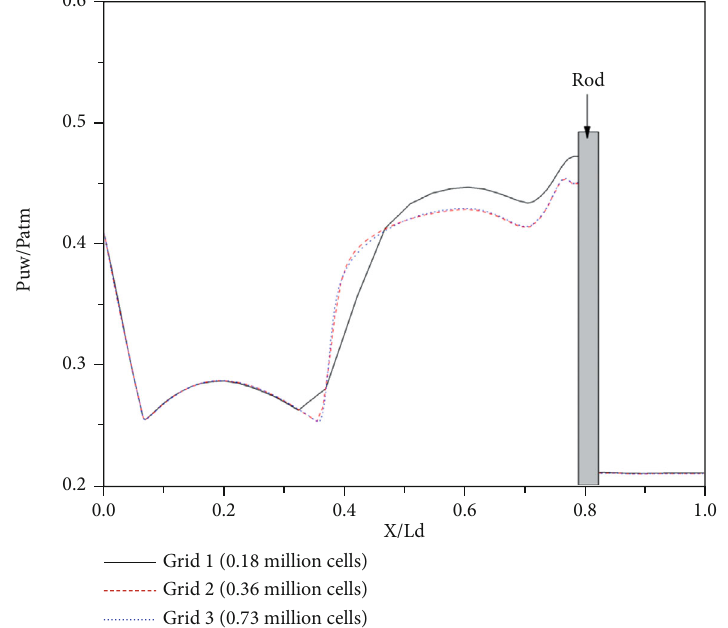
Figure 7: Static pressure distributions along the diverging part on the top wall for grid independence study ( NPR = 4 : 6 , H / R X / L = 0 : 8 r d